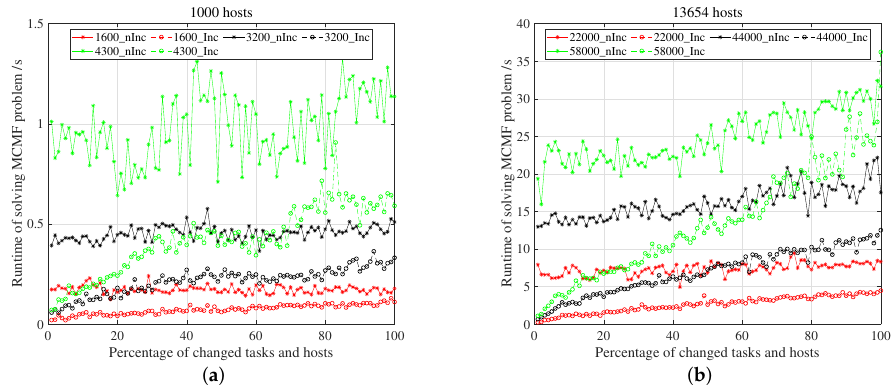
Figure 5. Runtime of NS when solving MCMF problems incrementally in different load levels. In the legends of figure, number denotes how many tasks are considered, and nInc or Inc indicates the corresponding MCMF problem is solved from draft or incrementally, respectively. ( a ) 1000 hosts. ( b ) 13,654 hosts.